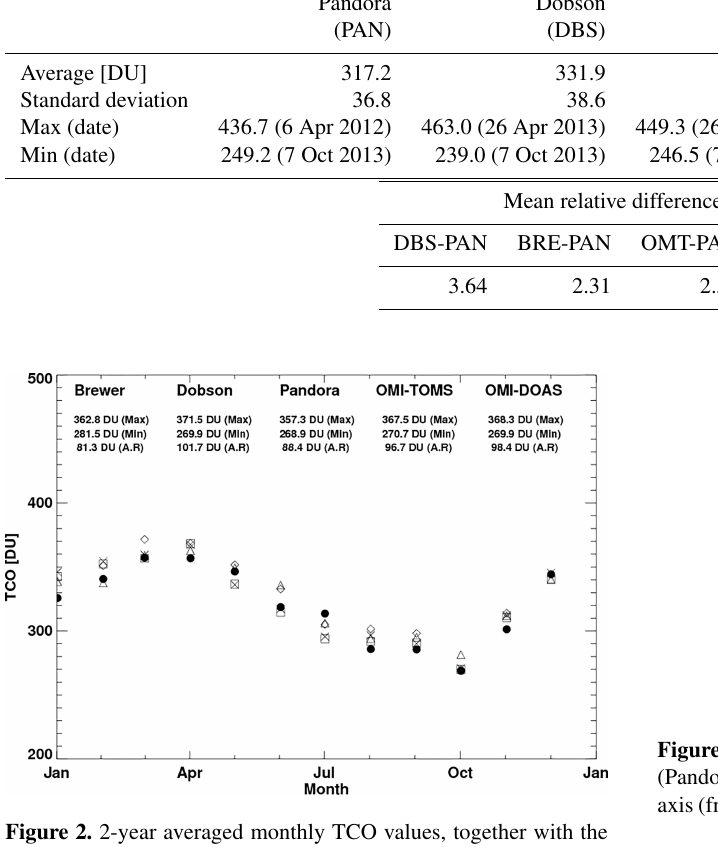
Figure 2. 2-year averaged monthly TCO values, together with the maximum, minimum values, and annual ranges (A.R) from the four instruments over the study period.